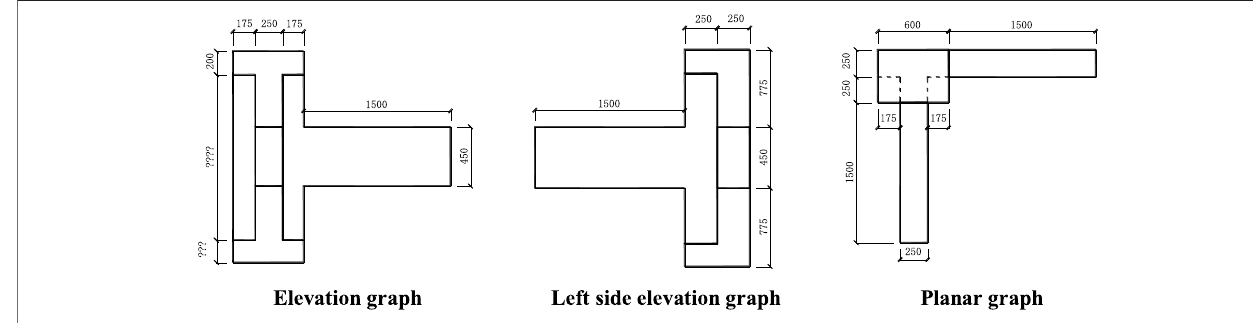
FIGURE 2 | Three-dimensional drawing of specimens (Xiang et al., 2017; Xiang et al., 2019).